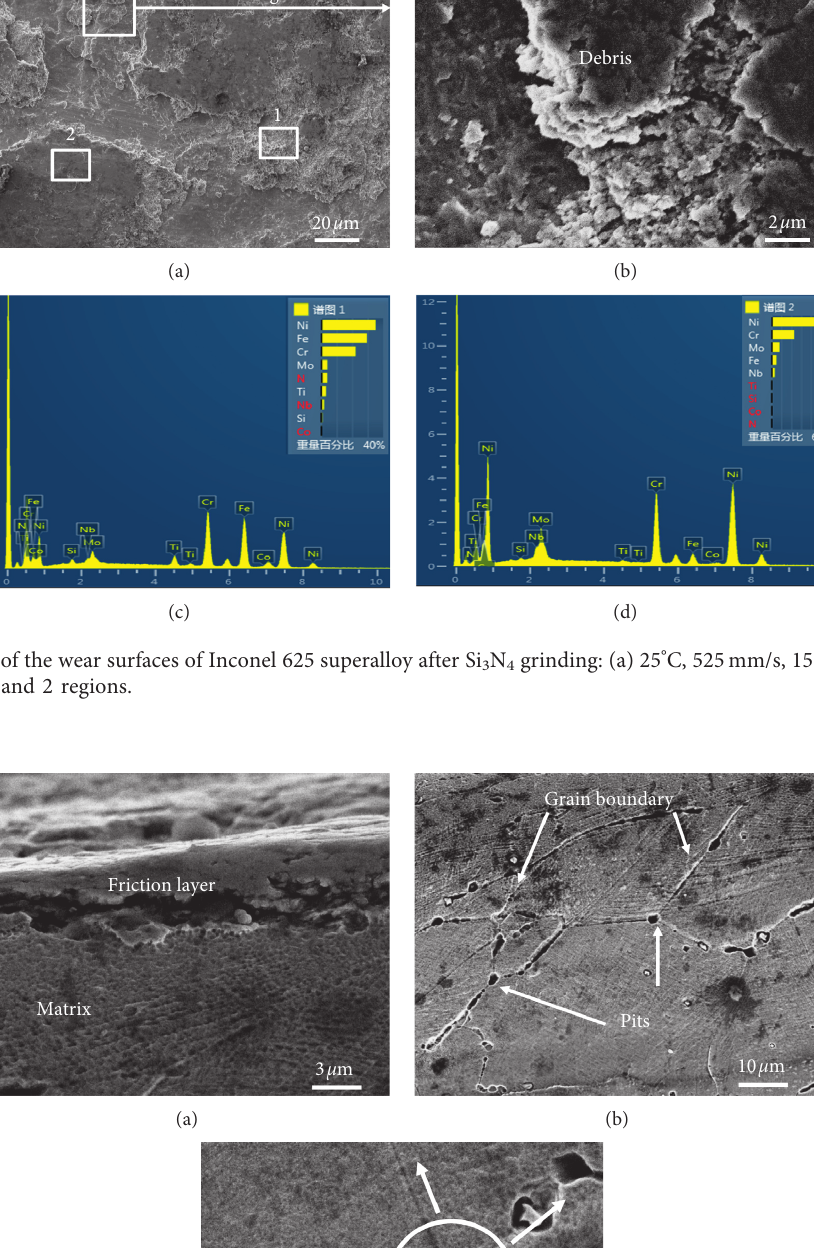
Figure 16: Cross-sectional SEM images of the worn Inconel 625 superalloy: (a) 25 ° C, 525mm/s, 15N; (b) SEM images after cross-section corrosion; (c) enlarged view of (b) after corrosion of the cross